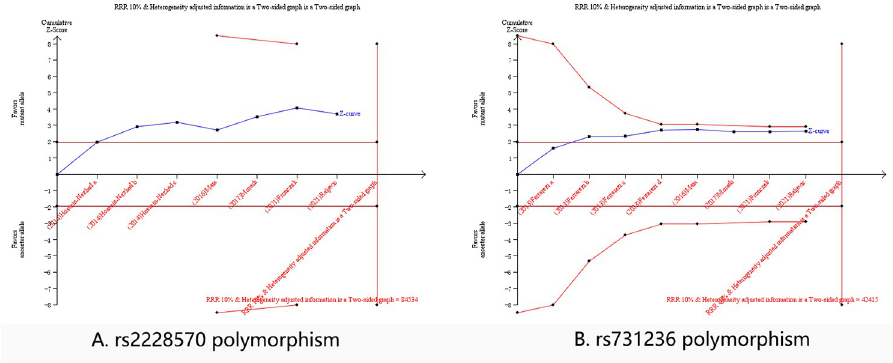
Fig 6. Trial sequential analysis of VDR rs2228570 and rs731236 polymorphisms in the White population. VDR = vitamin D receptor.